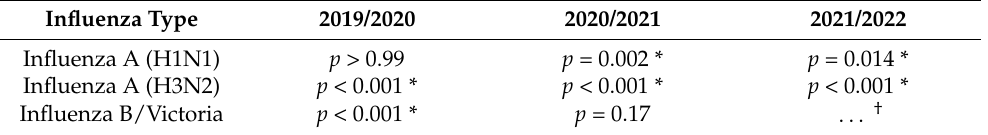
Table 3. Wilcoxon signed-rank test results assessing the statistical significance of differences in antibody titers compared with those in the 2017/2018